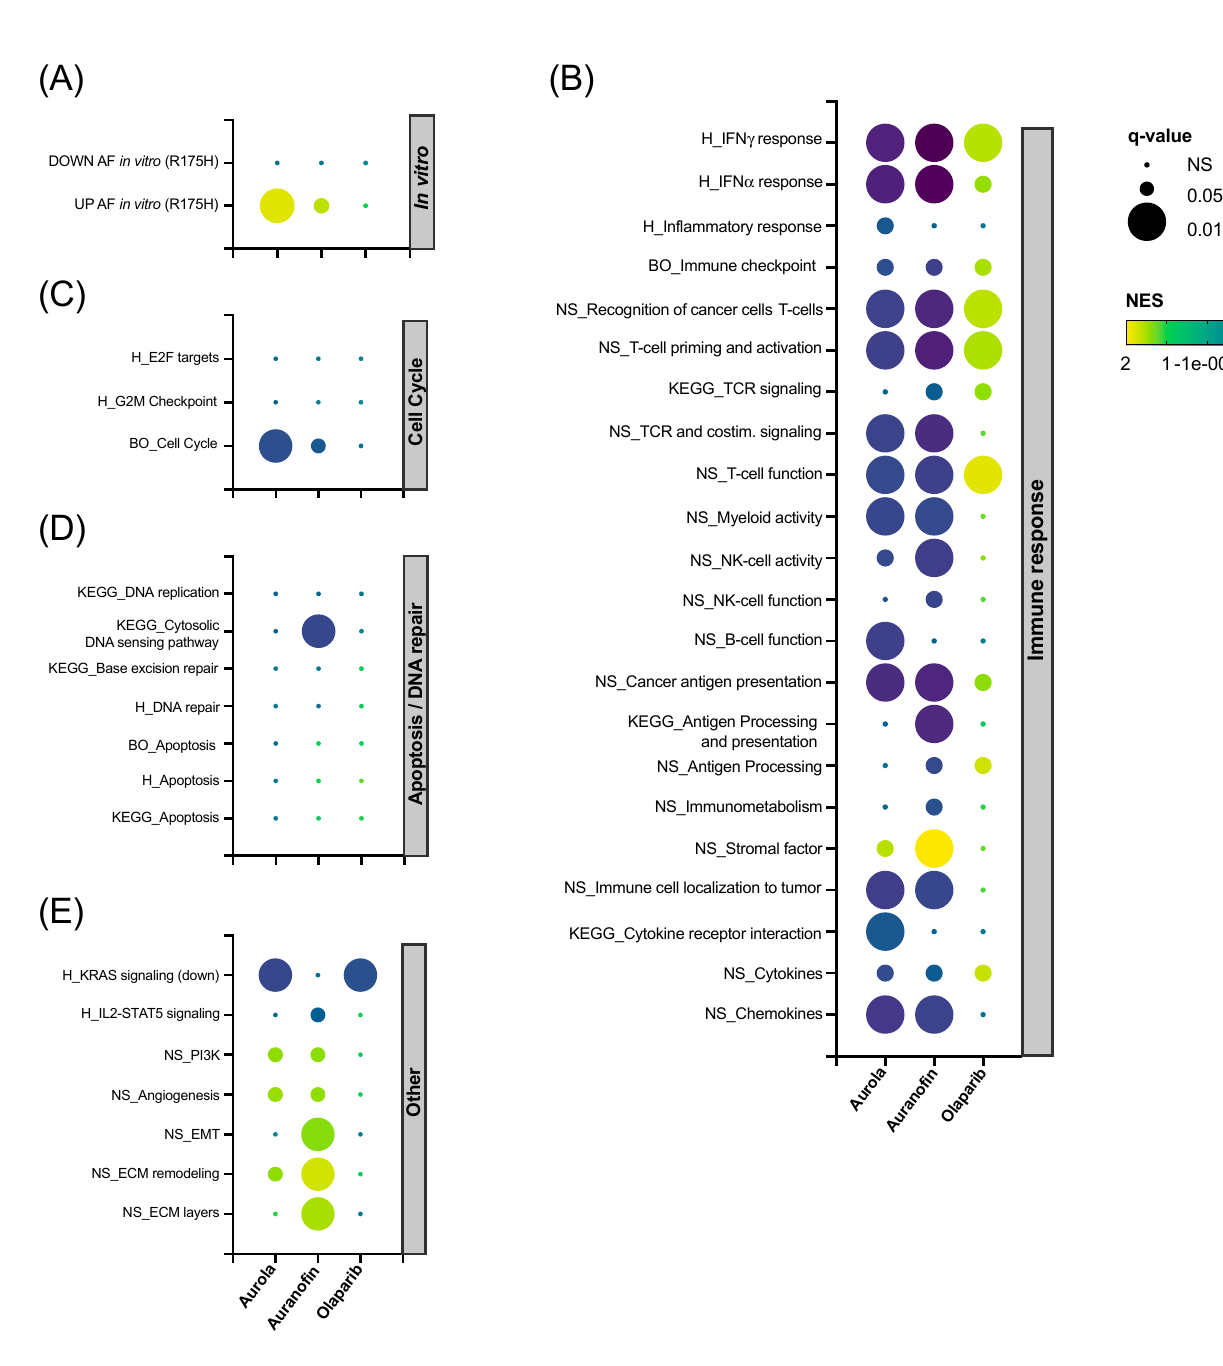
Figure 6. Effect of AF, olaparib and aurola treatment on immune-related, apoptosis, DNA repair and cell cycle gene sets in vivo. 344SQ tumors ( n = 6–8 mice per group) were harvested on day 14 of the treatment schedule for subsequent RNA isolation and sequencing. ( A – E ) Bubble plots showing the effect of AF, olaparib, and aurola treatment on a selected panel of verified in-house, Nanostring (NS), BigOmics (BO), Hallmark (H) and KEGG gene sets in 344SQ mice tumors, including gene sets related to the in vitro response of mutant p53 R175H NCI-H1299 cells after AF treatment determined via RNA sequencing ( A ), immune response ( B ), cell cycle ( C ), apoptosis/DNA repair ( D ), and others ( E ). Bubble size corresponds to the degree of significance (q-value). Bubble color corresponds to positive NES (upregulated gene sets in yellow–green) and negative NES (downregulated gene sets in blue–purple). NES: normalized enrichment score; EMT: epithelial-to-mesenchymal transition; ECM: extracellular